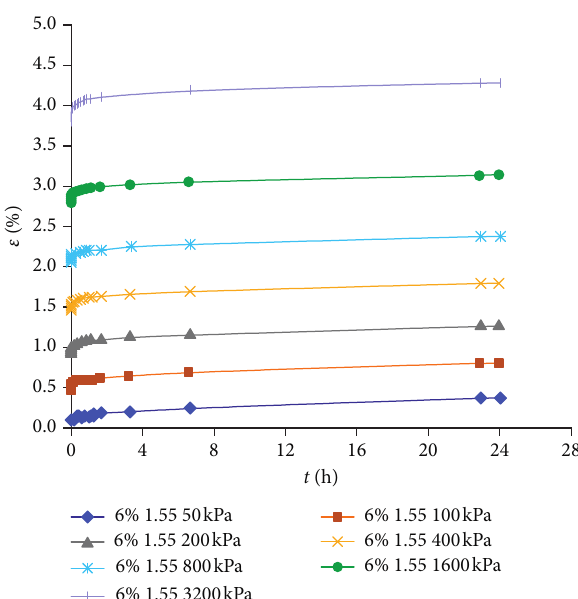
Figure 5: Stress-time curves of compacted loess with water content 6%.